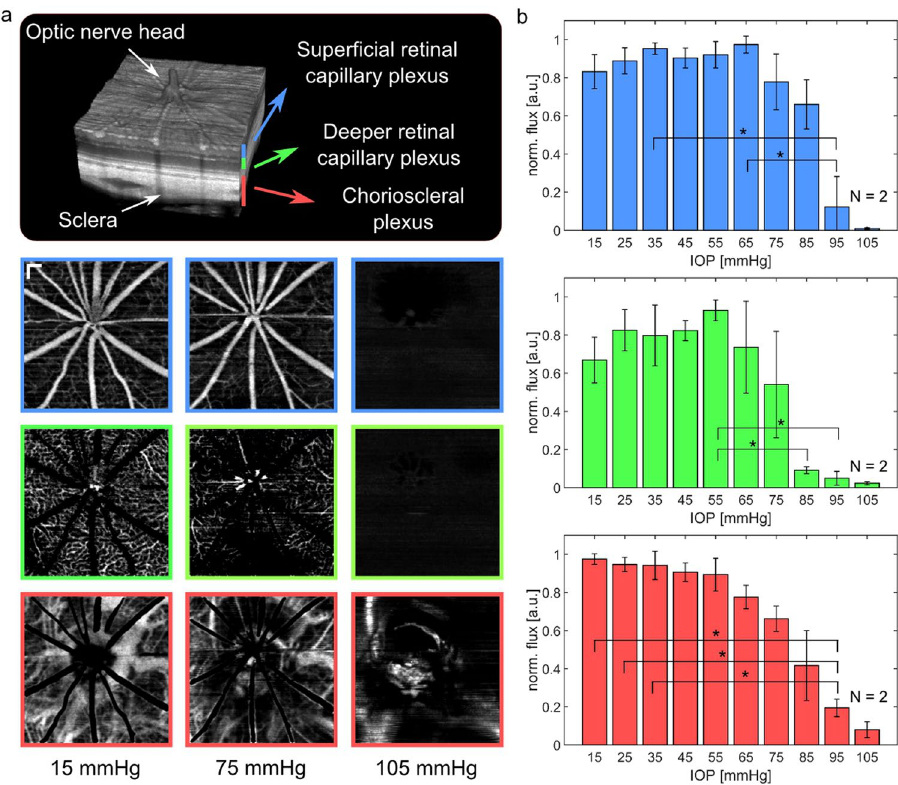
Figure 4. Changes of the retinal perfusion in response to increased IOP. ( a ) En-face OCTA maximum- intensity-projections of three plexuses at three different IOP levels. Non-perfused patches in the deeper retinal capillary plexus were observed at increased IOP levels of 75 mmHg. While the retinal perfusion stopped at an IOP level of 105 mmHg, some major choroidal vessels were still present in the OCTA images. (scale bar = 150 μ m ) ( b ) Quantitative analysis of the flux in all three plexuses in four animals. The flux in the superficial retinal plexus dropped significantly in the range of 65 to 95 mmHg while the flux in the deeper retinal capillary plexus earlier decreased significantly between 55 mmHg and 85 mmHg. ( * significant difference: p <